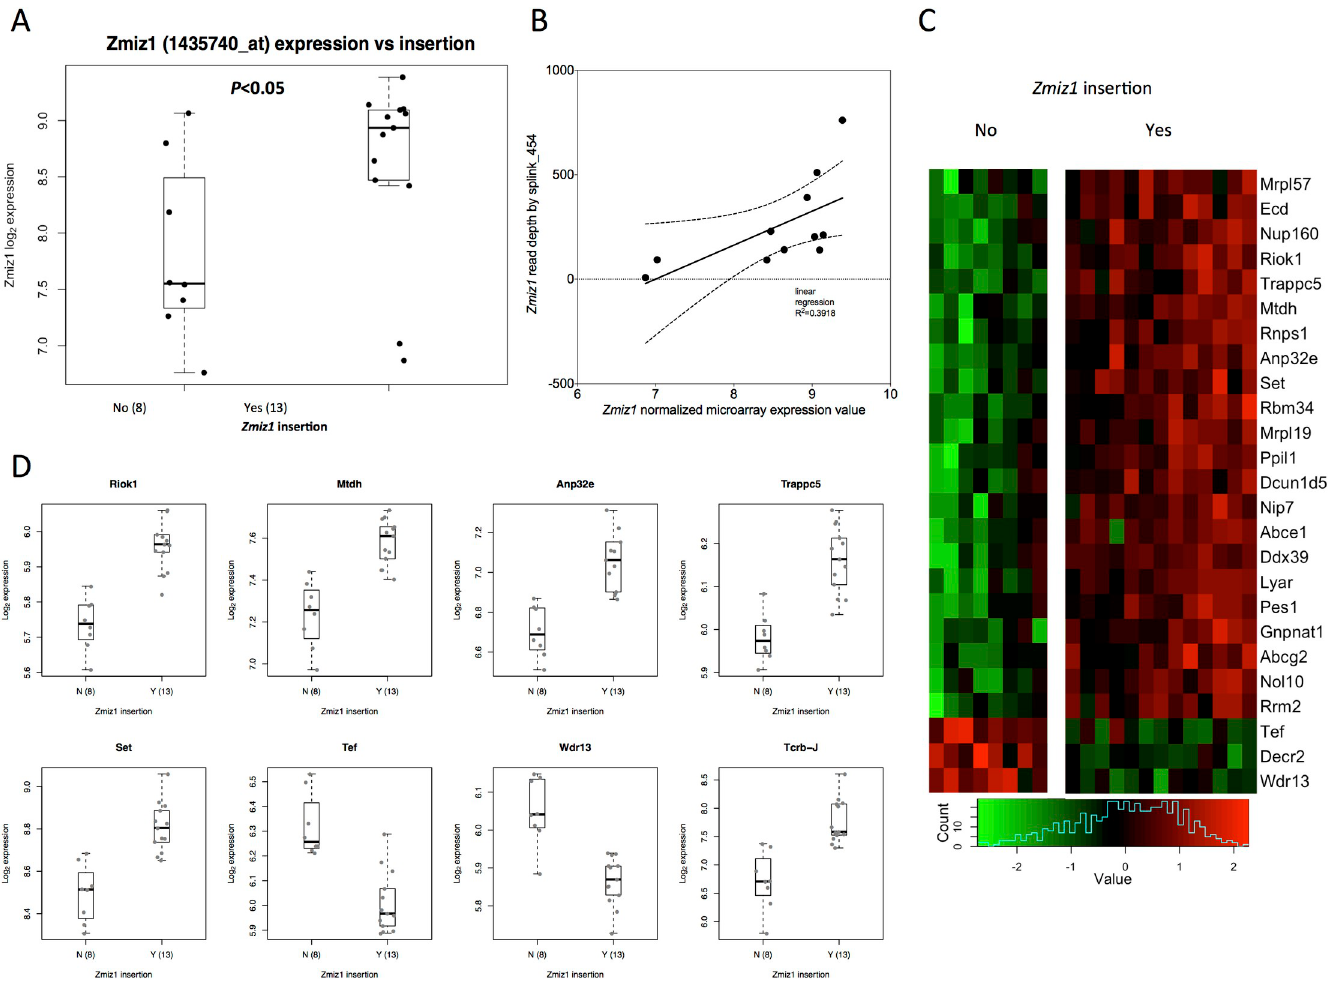
Fig 6. Microarray gene expression analysis revealed that tumors with Zmiz1 SB insertions (yes) had significantly higher expression of Zmiz1 compared to tumors without insertions (no) ( A ). Box boundaries indicate interquartile range; whiskers indicate maximum and minimum values; center lines indicate medians. ( B ) Insertion read depth for SB in the Zmiz1 locus positively correlates with Zmiz1 expression by microarray analysis. ( C ) Top 25 differentially expressed genes between genomes with (yes) or without (no) Zmiz1 SB insertions ( D ) Normalized gene expression of top differentially expressed genes, Riok1 , Mtdh , Anp32e , Trappc5 , Set , Tef , Wdr13 , Tcrb-J with corrected P < 0.05 from panel C , in cuSCCs with SB-driven Zmiz 4 N185 expression. Additional KA tumors from Pten -sensitized mice using keratinocyte- specific SB mutagenesis ( S1 Text